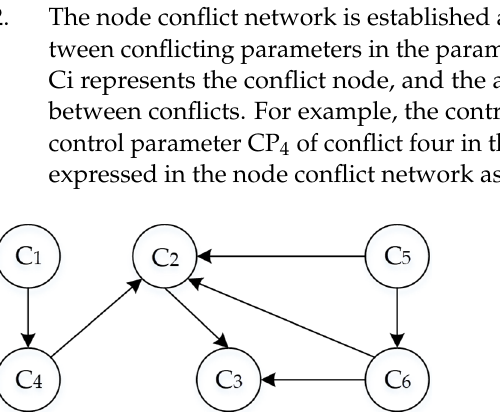
Figure 12. Multi-Conflicts Parameter Network.